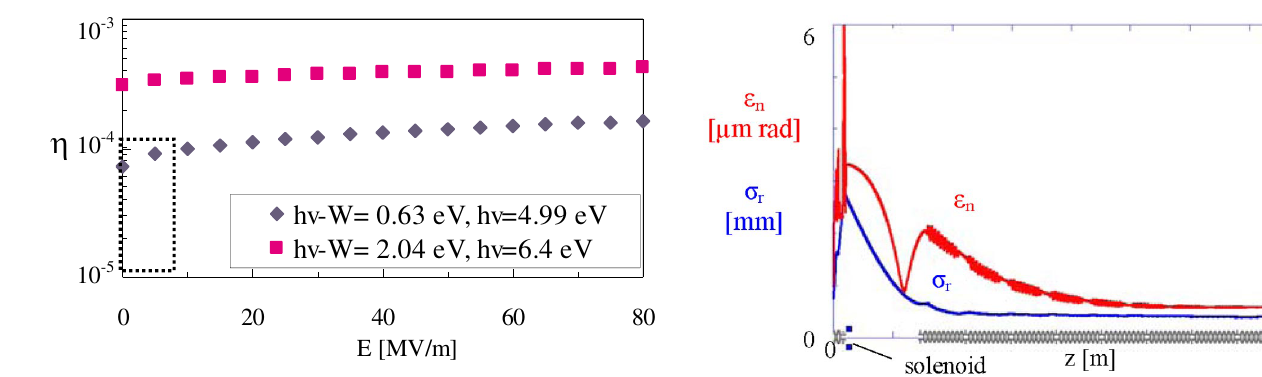
FIG. 5. (Color) Extrapolated change of (cid:13) versus applied electric field on the emitting spot. The curves are extrapolated for two photon energies ( h(cid:15) ). The marked area indicates dc measured data at